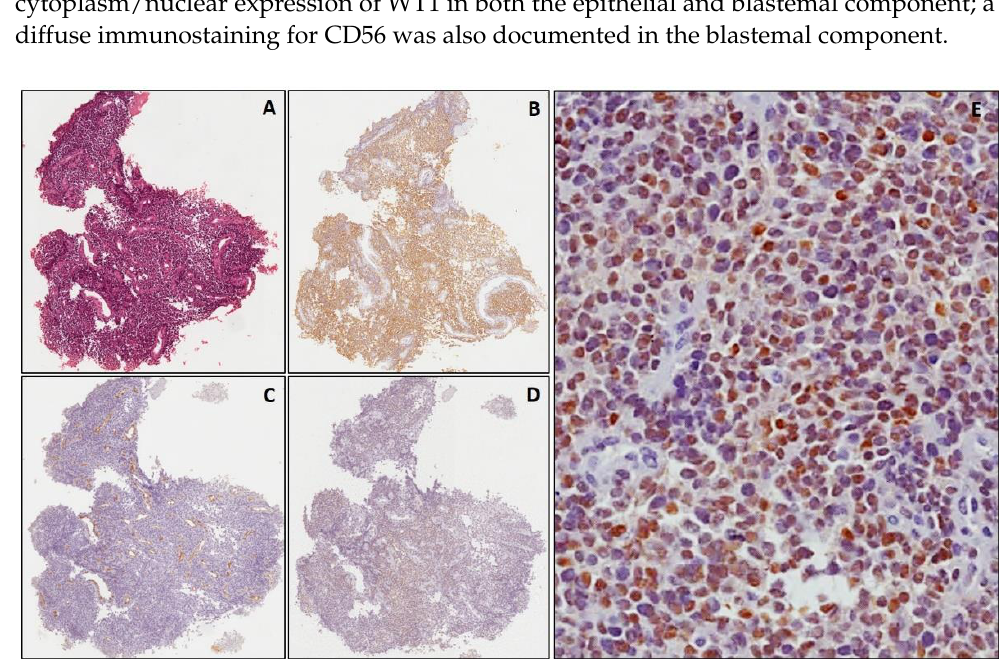
Figure 2. Ewing’s sarcoma, classic type. Serial sections from a small biopsy stained with hematoxylin & eosin ( A ). Neoplastic cells are diffusely positive for CD99 ( B ) and negative for WT1 ( C ); endothelial cells of intratumoral blood vessels are stained (internal control staining). In ( D , E ) diffuse nuclear staining for cyclin D1, at low and higher magnification, respectively. ( A – D : original magnification 40×; E : original magnification 200×).